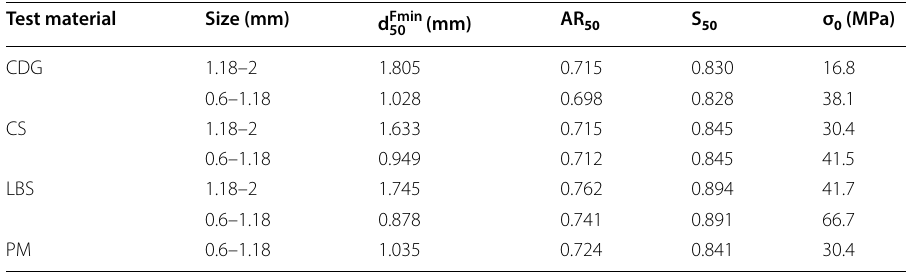
Table 1 Shape factors for test materials and the 37% average tensile strength (σ measured by single particle crushing